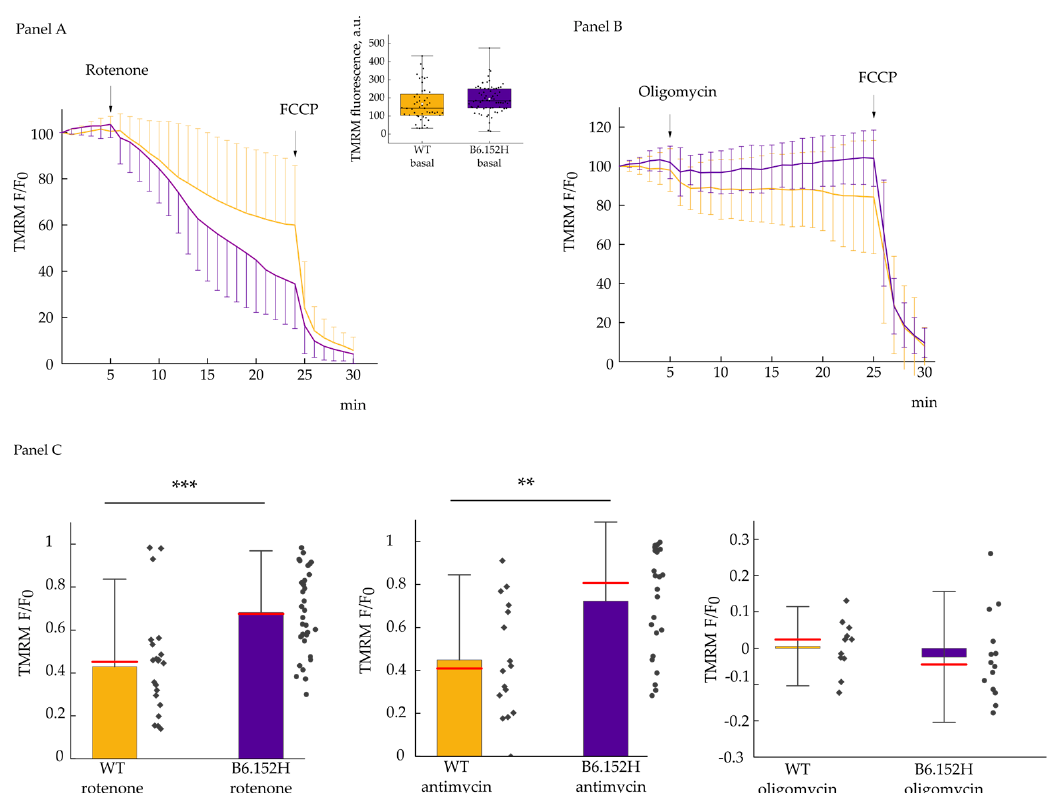
Figure 3. Effect of the inhibition of the ETC or of the F 1 F 0 ATP-synthase on the mitochondrial membrane potential. Panel ( A ) shows traces of TMRM fluorescence for WT, yellow, and B6.152H, indigo, neurons. Where indicated, the cells were challenged with 2 µ M rotenone and 4 µ M FCCP. Values are normalized over the mean fluorescence of the first five acquisitions; fluorescence intensity was acquired every min. Inset: Absolute TMRM initial values for WT, (yellow) n = 51 cells, and B6.152H (indigo) neurons n = 67 cells; test t p = 0.11. Box representing 25–75% of data, whiskers: 1–99% of data, white square: Mean; transverse line: Median. Panel ( B ) shows mean traces of TMRM fluorescence of WT and B6.152H neurons challenged with 1 µ g/mL oligomycin and 4 µ M FCCP. Panel ( C ) shows the quantification of the effects produced on the mitochondrial membrane potential by the above-mentioned inhibitors expressed as the normalized difference between initial fluorescence F0, minus the fluorescence measured at 25 min,. Rotenone experiment WT n = 22, B6.152H n = 34 p = 1.5 × 10 − 4 test t (normal distribution); antimycin experiments: WT n = 16, B6.152H n = 24 p = 0.003 Mann–Whitney test. Oligomycin experiments: WT n = 11, B6.152H n = 14 p = 0.48, test t (normal distribution). Cells were derived from at least three independent preparations, both for WT and the B6.152H genotype. Columns represent mean value plus/minus standard deviation; red line represents the median of the values. ** p ≤ 0.01, *** p ≤